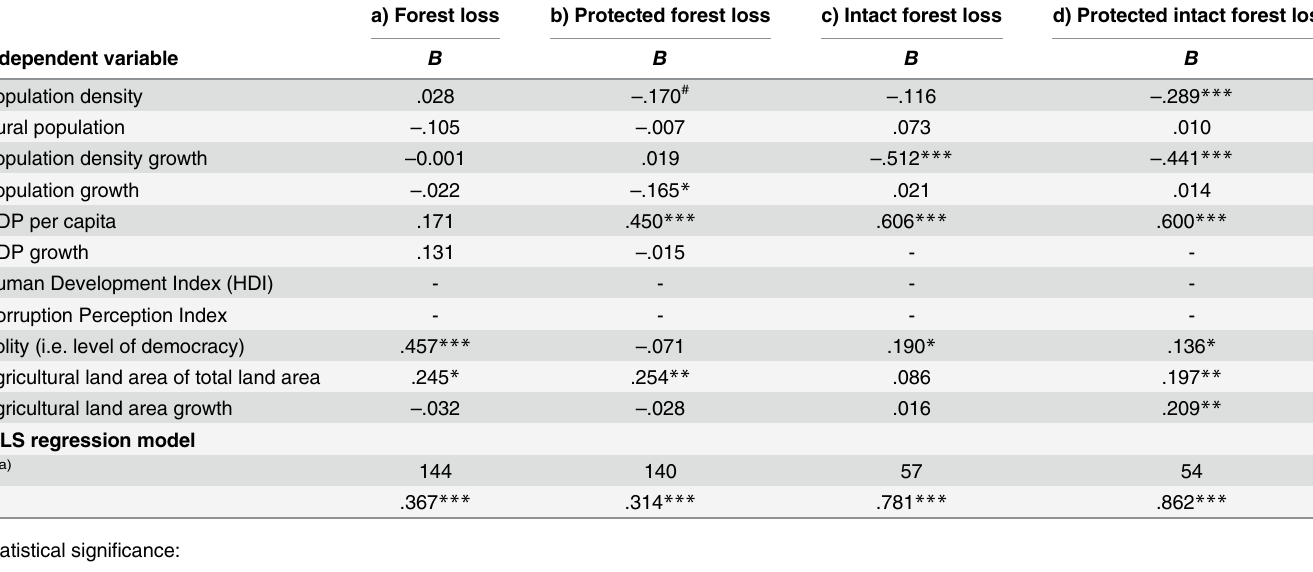
Table 5. The associations of common socio-economic parameters to forest loss between 2000 – 2012. The four WLS regression models have each a different dependent variable: (a) relative total forest loss, (b) relative loss in protected forest, (c) relative loss in intact forest, and (d) relative loss in protected intact forest. The weight used in the regression for the forest loss measures was the total forest extent in question. Standardised beta coefficient ( B ) is given for each independent variable included in each of the four models. The independent variables are explained in Table 3. The country specific data are given in S1 Table and S2 Table of the